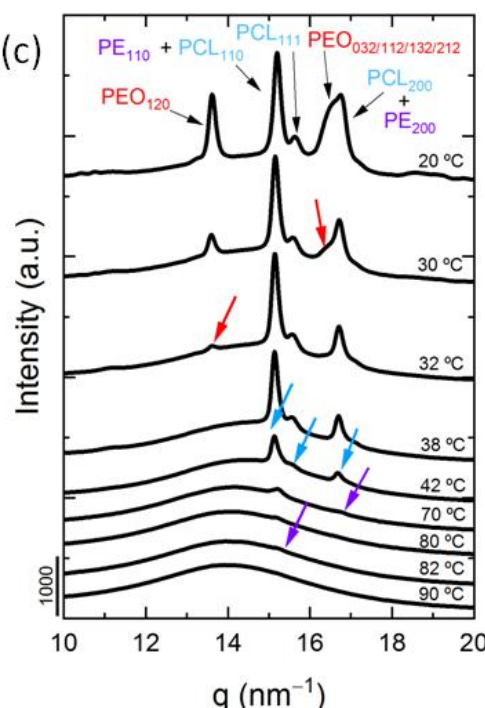
Figure 5. WAXS patterns upon cooling from the melt at 20 °C/min for ( a ) PE 7.1 , ( b ) PE 327.1 -b- PEO 6815.1 , and ( c ) PE 227.1 - b -PEO 4615.1 - b -PCL 3210.4 (T1) at different temperatures with colored arrows indicating crystallization of each block and the (hkl) planes.